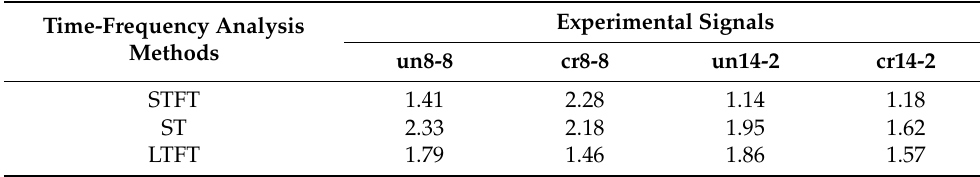
Table 3. R é nyi entropy of the experimental signals time-frequency Table 3. Rényi entropy of the experimental signals time-frequency spectrum.